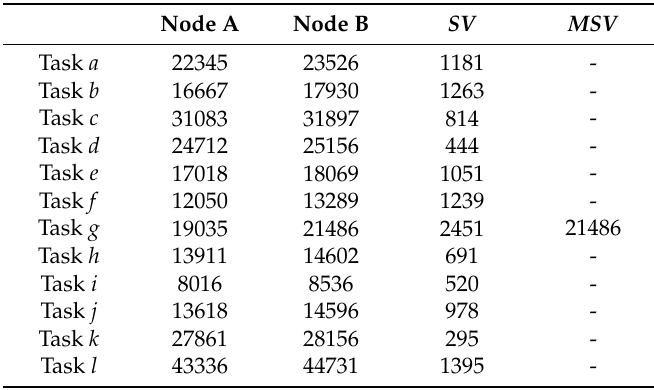
Table 6. Calculation of the MSV values of